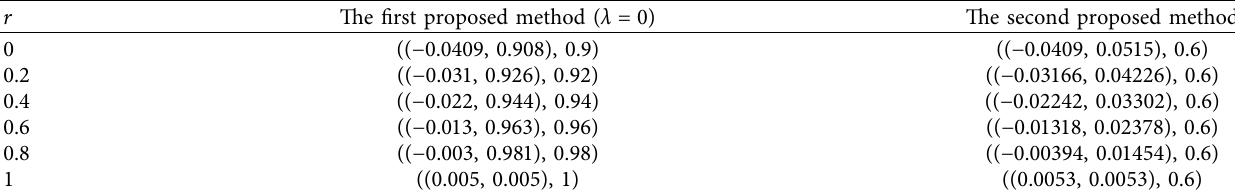
( r ) result using the two proposed methods ( λ � 0). 1